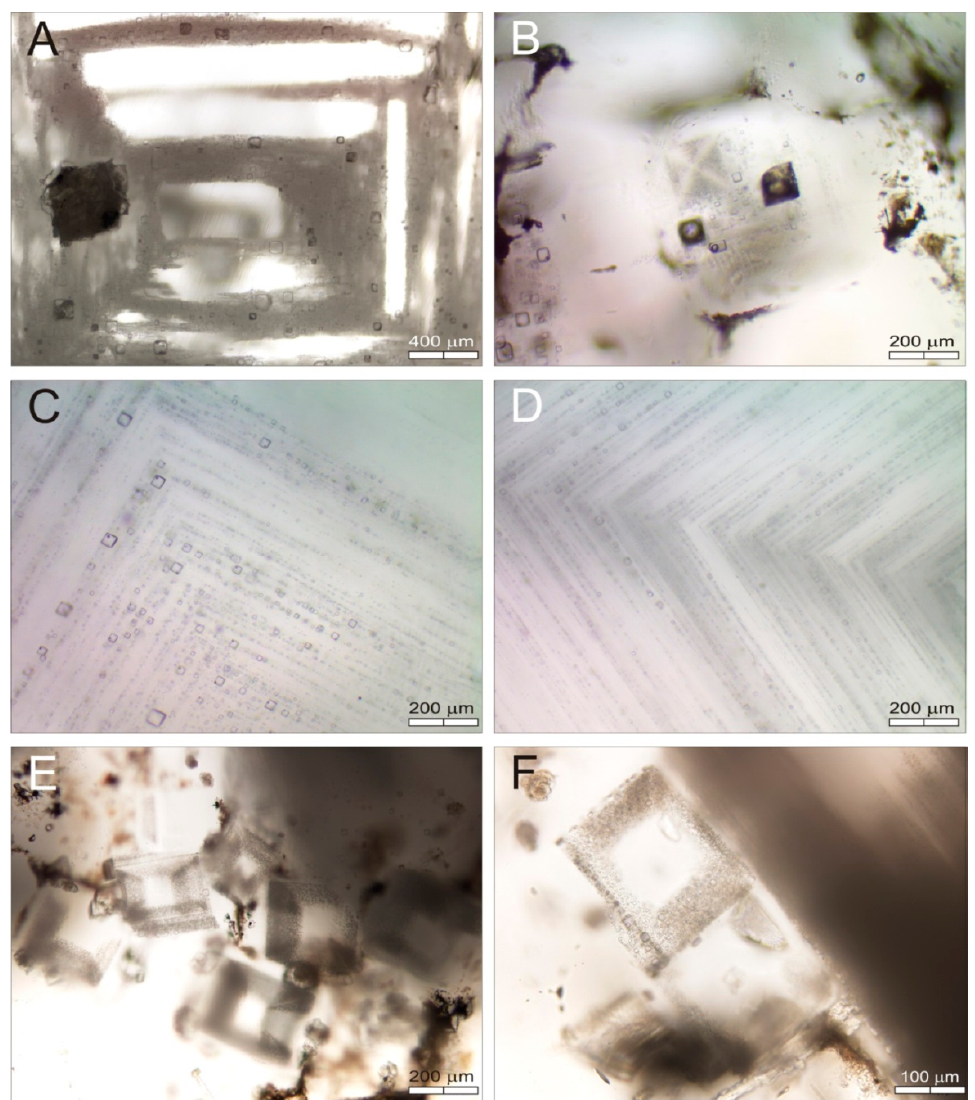
Figure 2. Fluid inclusions in sedimentation textures of halite: ( A , B ) within cumulate halite (( A )—Upper Kama Basin, Kungurian, sample no. 34/87; ( B )—Transcarpathian Basin, Badenian, Well 6-T, depth interval: 1110–1114 m); ( C , D ) within chevron halite (( C )—Transcarpathian Basin, Badenian, sample no. H-III-70; ( D )—Transcarpathian Basin, Badenian, Well 6-T, depth interval: 1145–1149 m); ( E , F ) within salting-out halite (Upper Pechora Basin, Kungurian, sample no. 3/14).